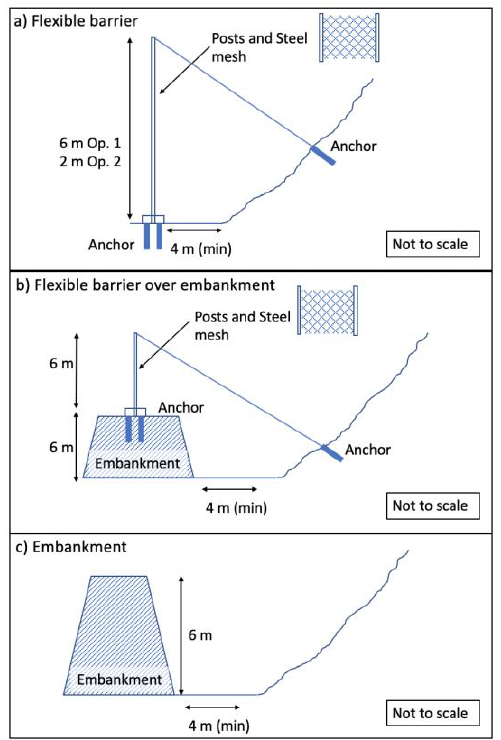
Figure 14. Sketches of available approaches to achieve the height and energy requirements for Op- tions 1 and 2 in Tables 8 and 9. Options 1 and 2 in Tables 8 and